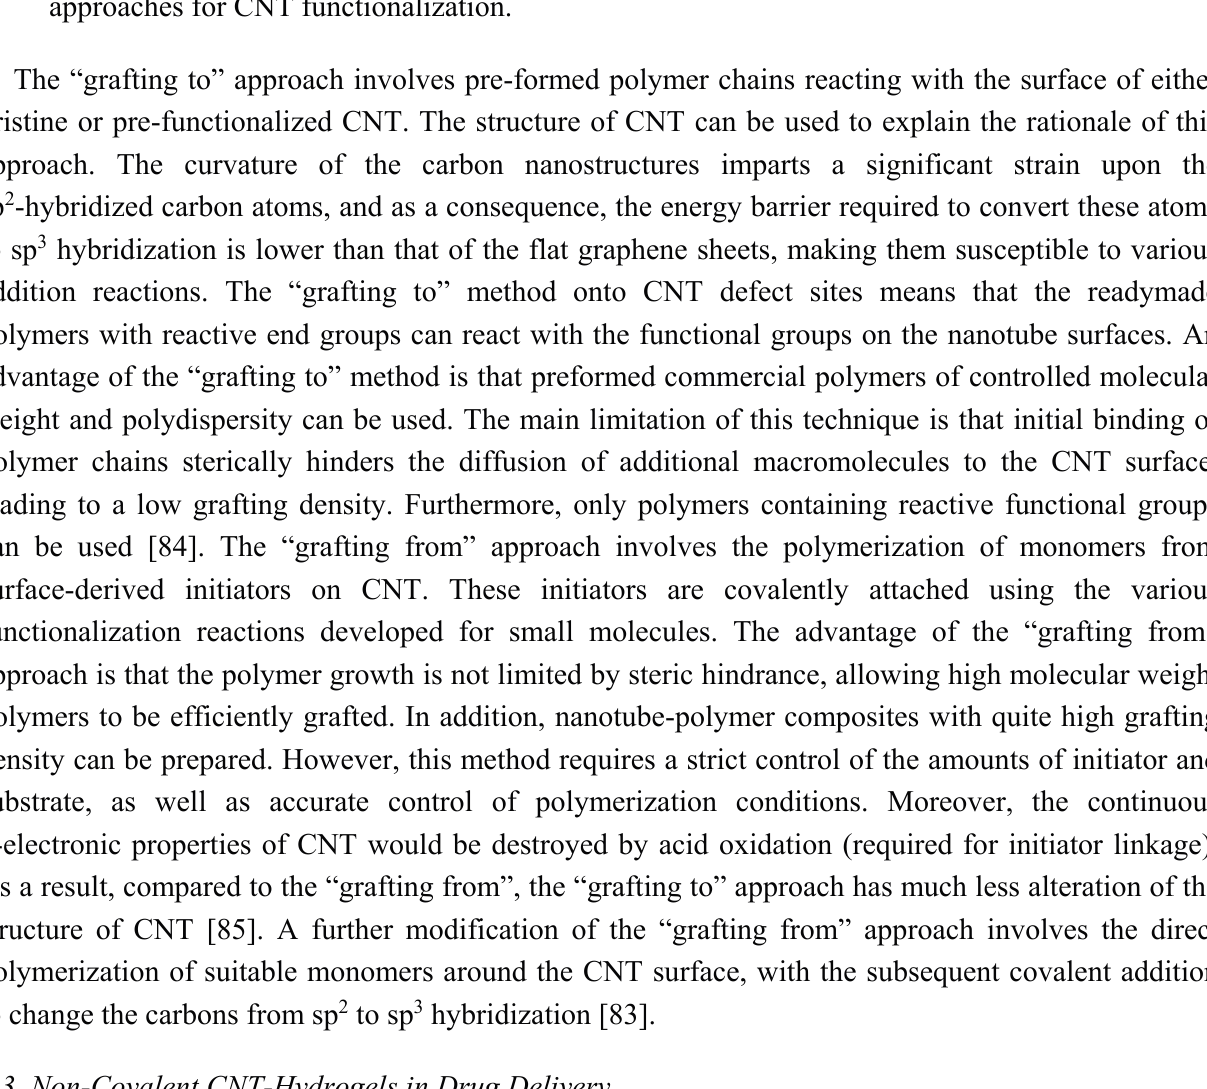
Figure 3. Schematic representation of the “grafting from” ( A ) and “grafting to” ( B ) approaches for CNT